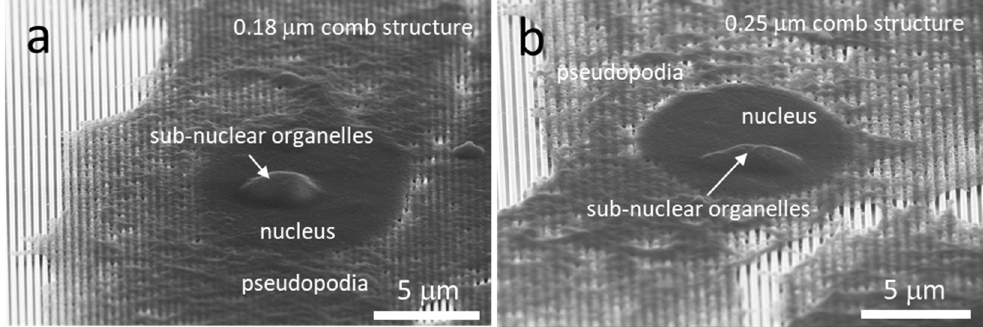
Figure 4. Typical 70° tilted low-magnification SEM micrographs of cells on comb structures with trench widths of ( a ) 0.18 µ m and ( b ) 0.25 µ m. Note that cellular material within the trenches is not visible. A cross-sectioning technique is needed to visualize the underbelly of the cell.